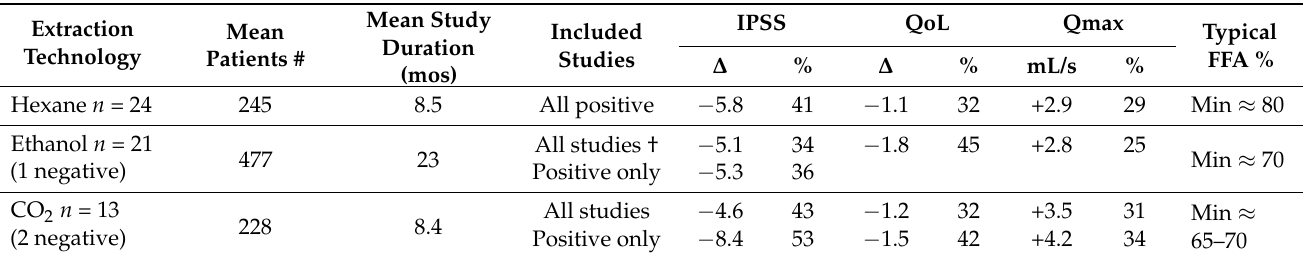
† The one negative ethanol study (Barry) did not significantly alter the IPSS outcome. The free fatty acid (FFA) minimums are typical values for lipidosterolic products (data on file 2021, Valensa International). The clinical endpoints of IPSS, QoL and Qmax are rounded off to two significant digits. Percentages are rounded off to the nearest whole number. ≈ , approximately; ∆ , mean change; − , negative change; %, percent; +, positive change; CO 2 , carbon dioxide; FFA, free fatty acid; IPSS, International Prostate Symptom Score; mL/s, milliliters per second; mos, months; QoL, quality of life; Qmax , peak urinary flow